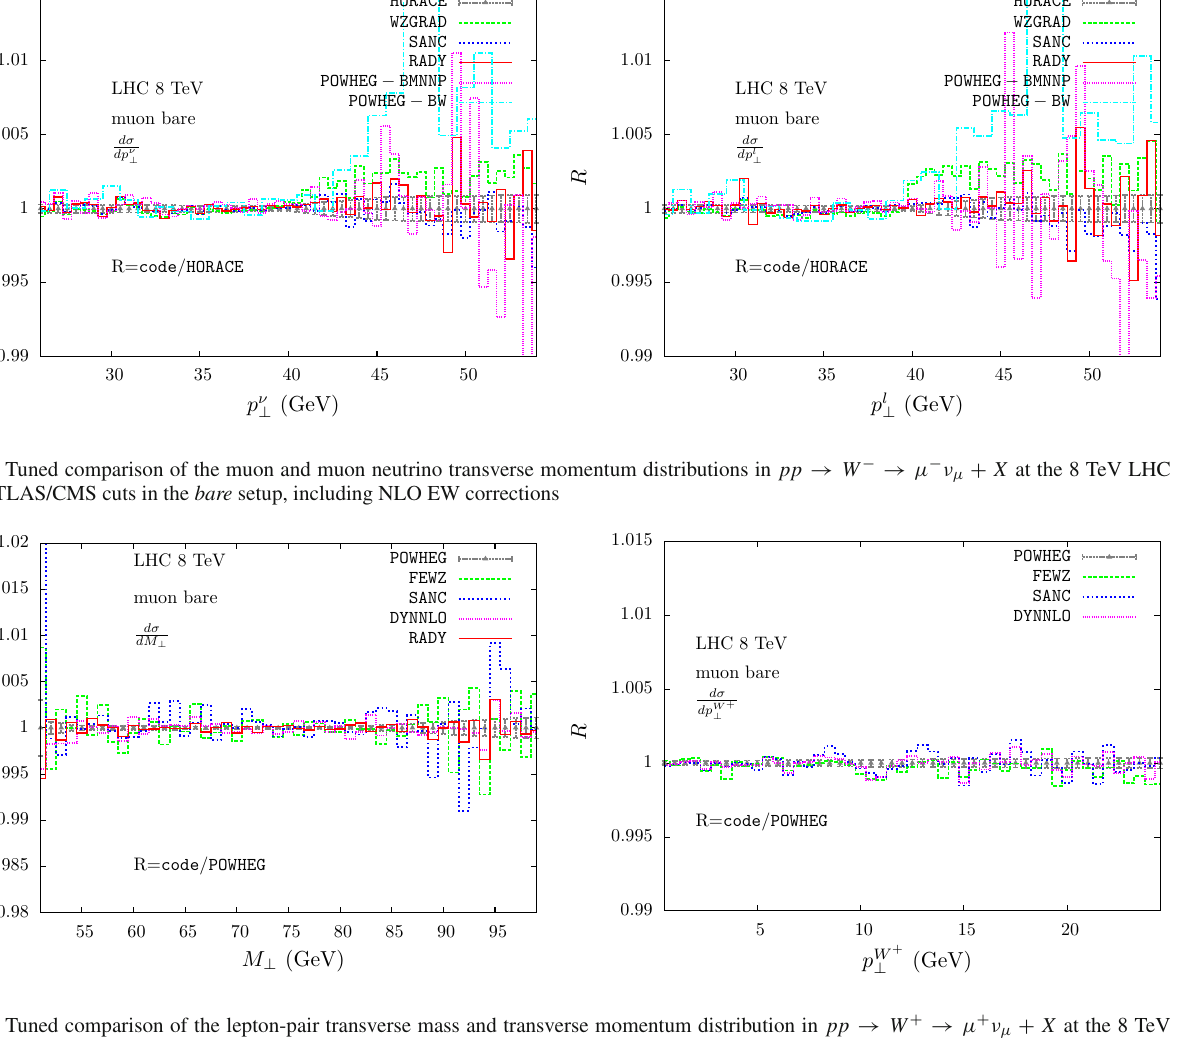
Fig. 5 Tuned comparison of the lepton-pair transverse mass and transverse momentum distribution in pp → W + → μ + ν μ + X at the 8 TeV LHC with ATLAS/CMS cuts in the bare setup, including NLO QCD corrections